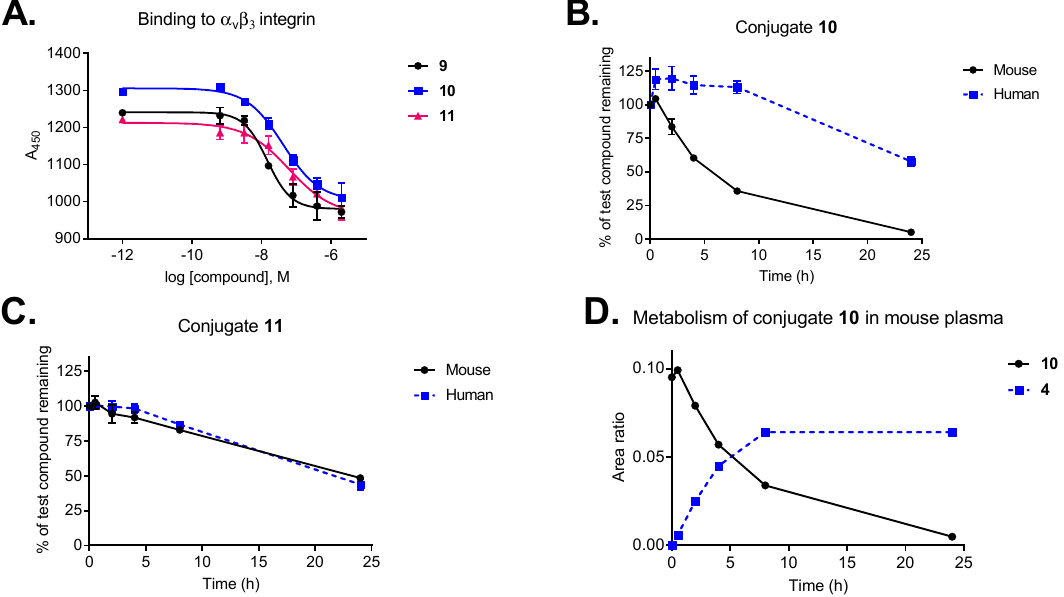
Figure 2. ( A ) Integrin α v β 3 binding affinity of conjugates 10 and 11 compared to the free ligand ( 9 ). ( B ) Plasma stability of conjugate 10 in mouse and human plasma. ( C ) Plasma stability of conjugate 11 in mouse and human plasma. ( D ) Metabolism of conjugate 10 in mouse plasma and the release of cryptophycin-55 glycinate ( 4 ). Data points are averages of three experiments, error bars indicate SD.